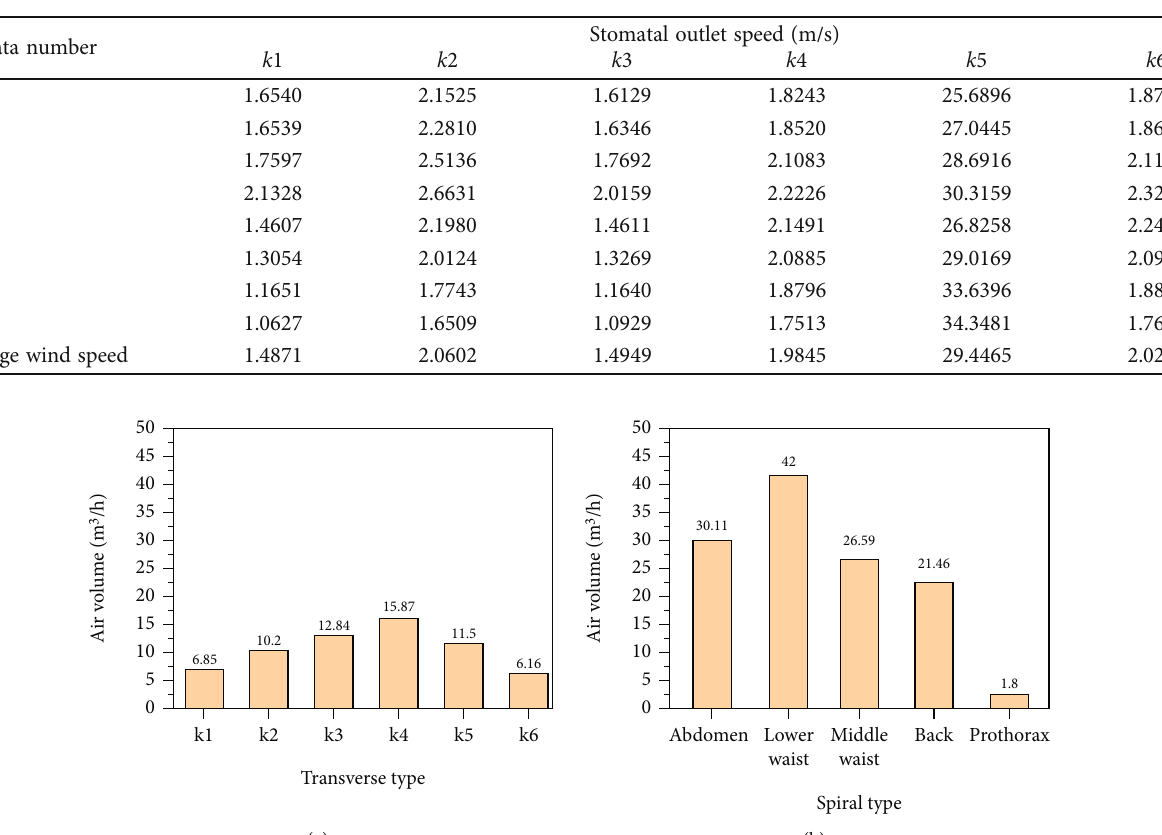
Table 2: Datasheet of longitudinal type (10 m 3 /h).